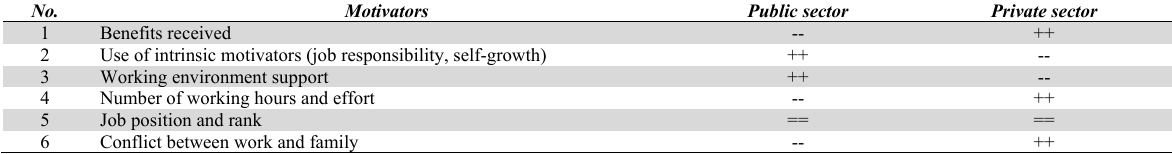
Differences in motivators between the public and private sectors in the study of Buelens and Broeck (2007) No. Motivators Public sector Private sector 1 Benefits received -- ++ 2 -- 3 -- 4